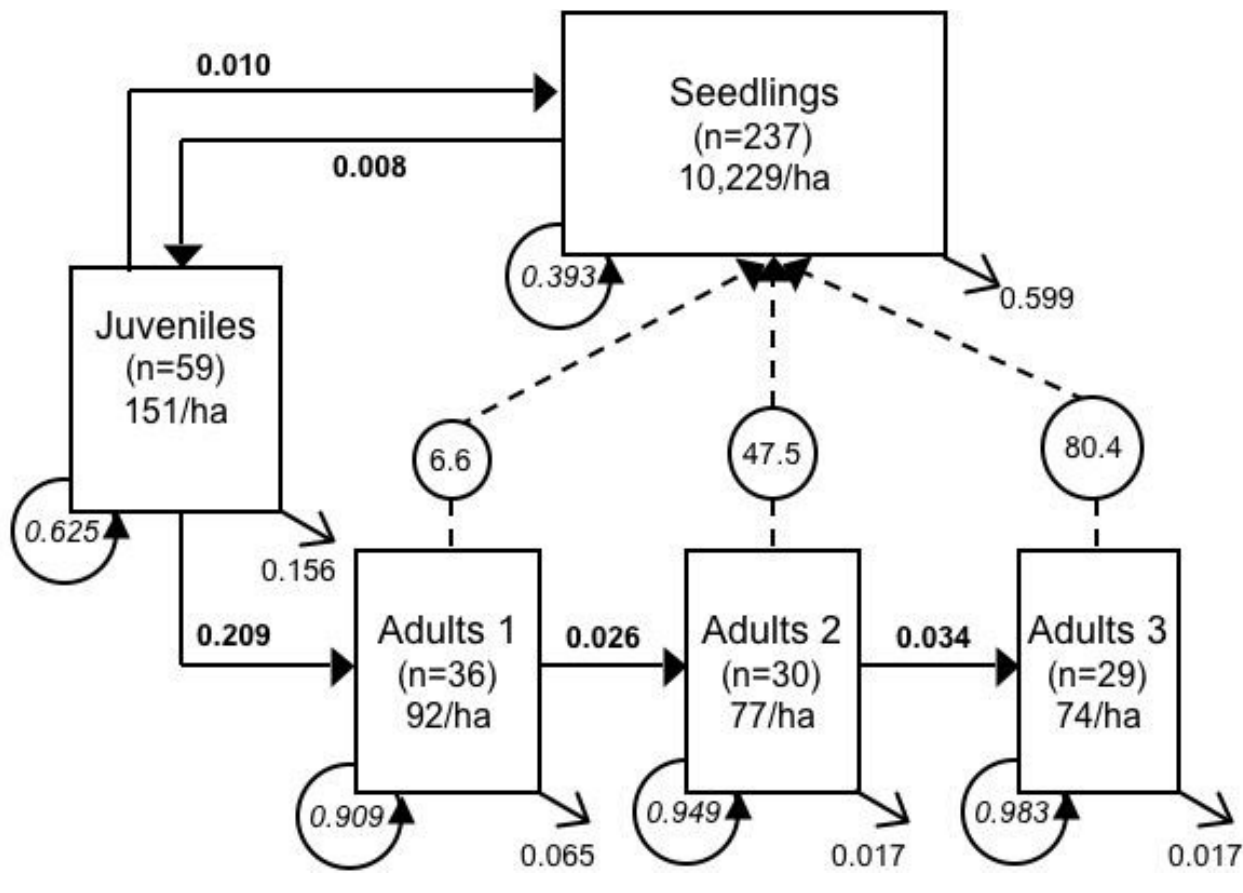
Fig. 1. Life cycle flux diagram of the Rhizophora mangle baseline population. The boxes represent life history stages. Inside is the density of individuals/ha in each stage and sample size of individuals. The relative size of the boxes represents population density on a log scale. The arrows between boxes represent annual transition probabilities between stages (bold numbers). Circular arrows represent annual probabilities of permanence in same stage (italic figures). Arrows leaving boxes indicate yearly mortality rates (ind ind -1 y -2 ). Circles above the adult stages represent the average number of established seedlings produced/tree, or fecundity. Total seedling density is the sum of all products of fecundity and adult density. The permanence, mortality, and transition rates are the geometric means of the data from 2 yr. The fecundity values are the arithmetic mean of the 2